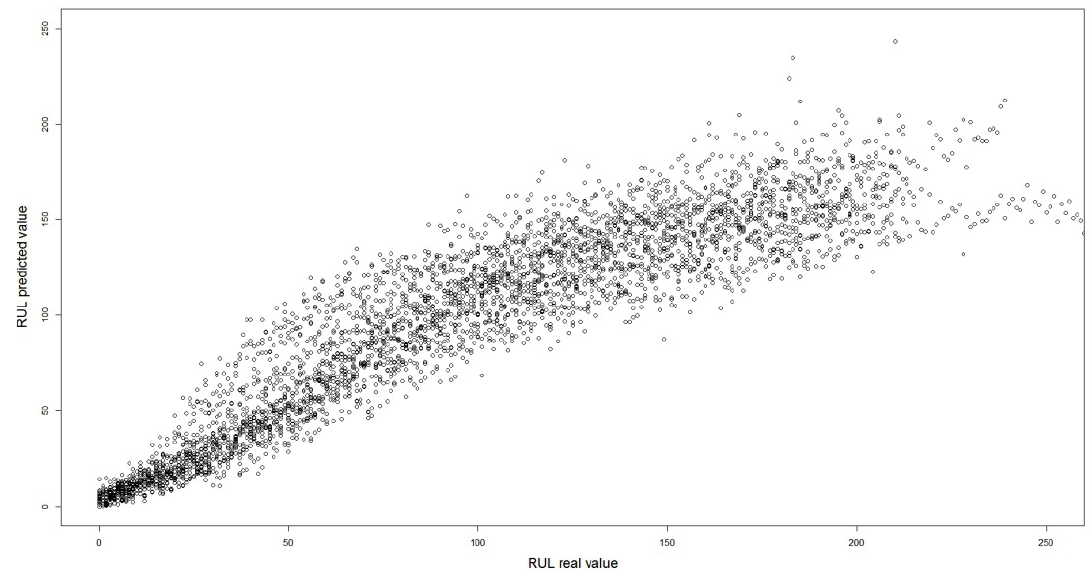
Figure 7. Remaining useful life of one of the validation subsets versus the remaining useful life calculated by the hybrid